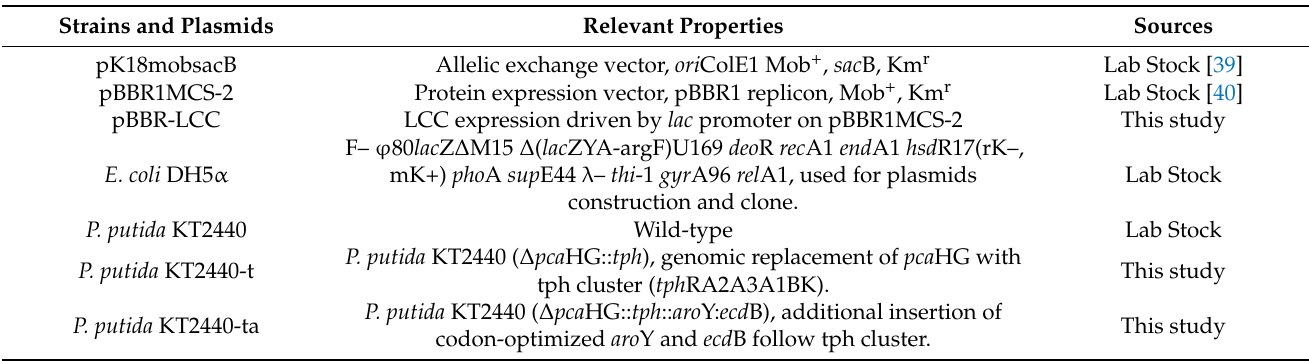
Table 1. Strains and plasmids used in this